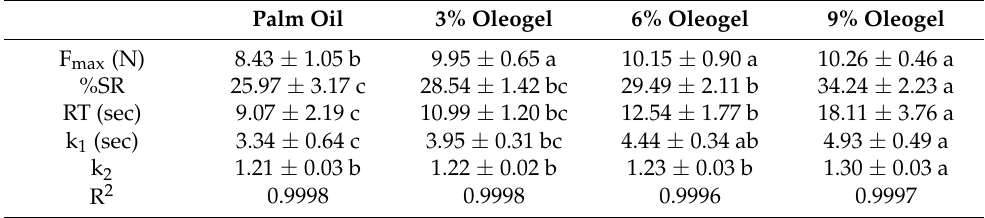
Table 3. Effect of palm oil replacement with oleogels on the stress relaxation parameters of imita- tion cheeses. Palm